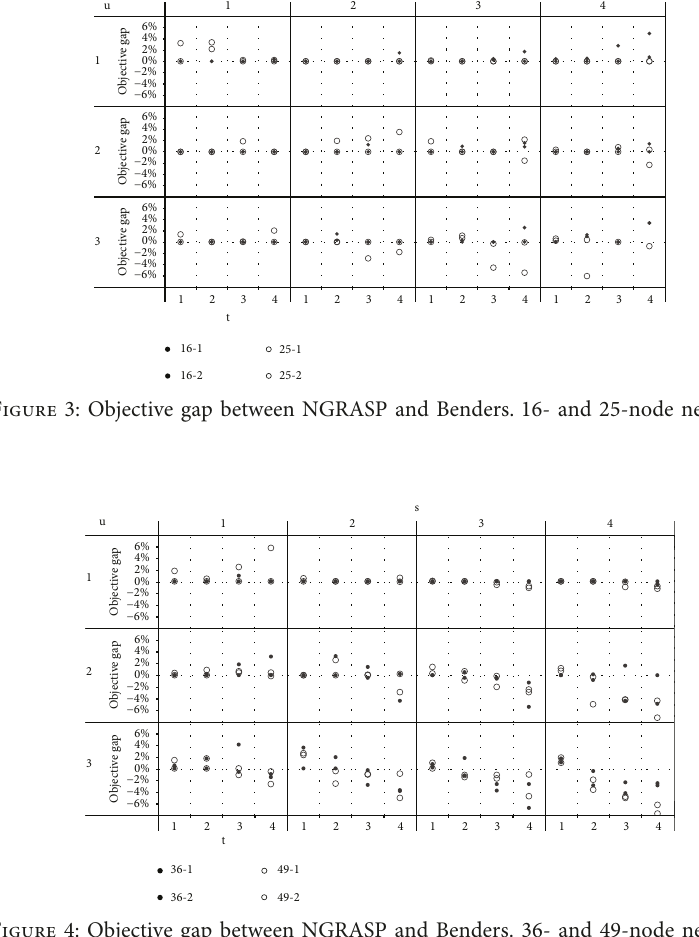
and r are available. 1 2